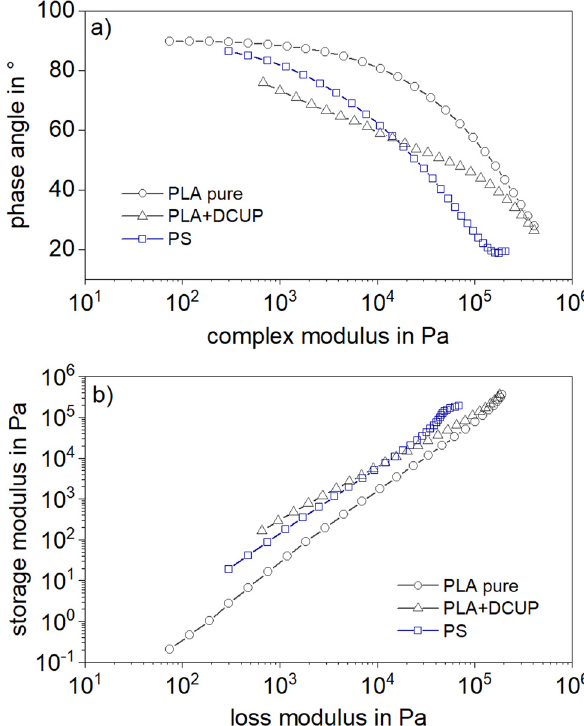
Figure 1: Van Gurp - Palmen plot ( a ) and comparison of storage and loss modulus ( b ) of PLA, modi fi ed PLA ( PLA + DCUP ) , and PS at 180°C.